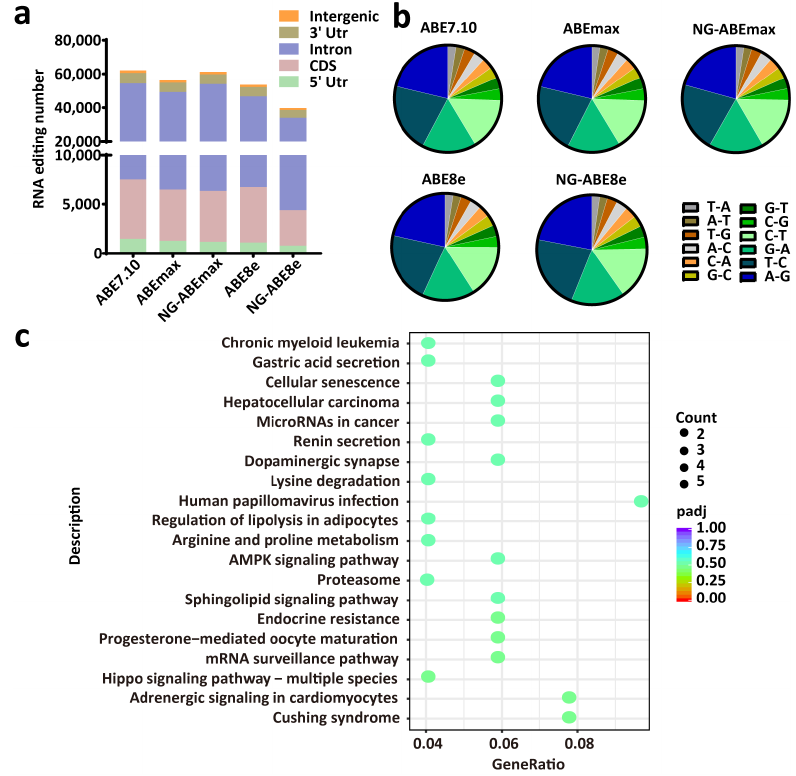
Figure 6. RNA editing activities induced by ABEs in APOE- gene-edited PFFs. ( a ) The numbers and distributions of RNA editing sites in genomic regions induced by ABEs in the PFFs. n = 3, independ- ent replicates. ( b ) The pie chart shows the frequencies of different types of RNA editing. ( c ) The top 20 enriched KEGG pathways of RNA editing sites induced by ABE8e. The x -axis represents the en- richment factor. The y -axis corresponds to the KEGG pathways. The colors of the dots represent the adjusted p -values, and the sizes of the dots represent the number of edited genes mapped to each reference pathway. R package ggplot2 (3.3.1) was performed to draw the bubble chart of the KEGG enrichment analysis.